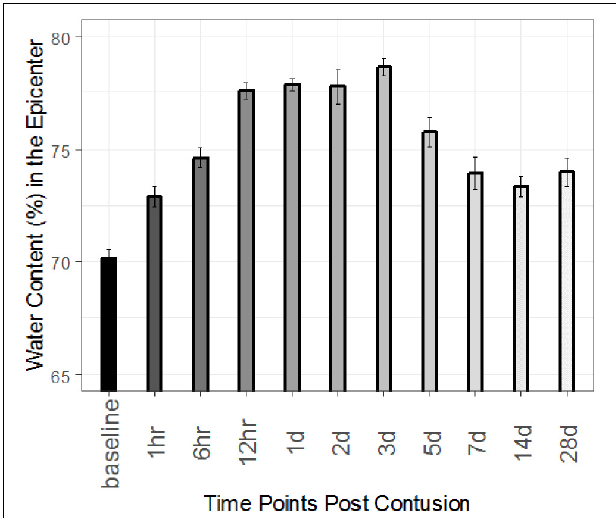
FIGURE 2 | Time course of spinal cord edema following severe SCI at T8 for epicenter. Percent (%) water content calculated in sham rats and injured rats at 1, 6, 12, 24, 48, and 72 h and 5, 7, 14, and 28 days post injury. Error bars indicate standard error (SE). For all times, n = 3.